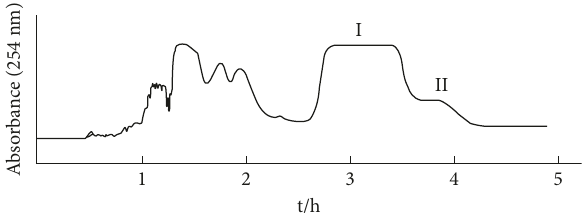
Figure 4: HSCCC chromatogram of ethyl acetate extract of A. officinarum Hance. Solvent system: petroleum ether–ethyl acetate–methanol–water (0.8 : 1 : 1 : 0.8, v / v ); revolution speed: 850r/min; flow rate: 2.0 mL/min; sample size: 270mg; UV de- tection wavelength: 254nm.